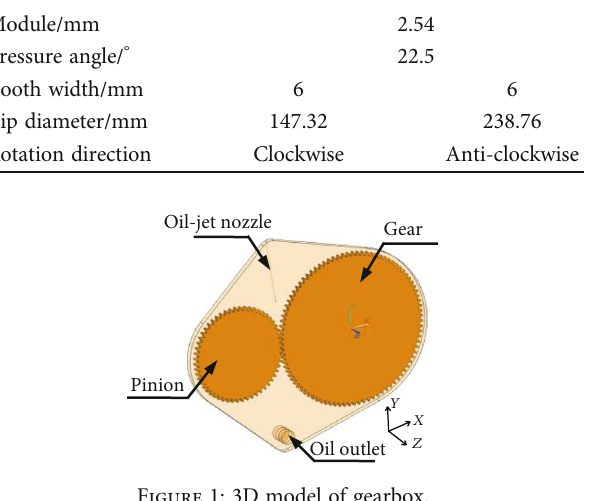
Figure 1: 3D model of gearbox.